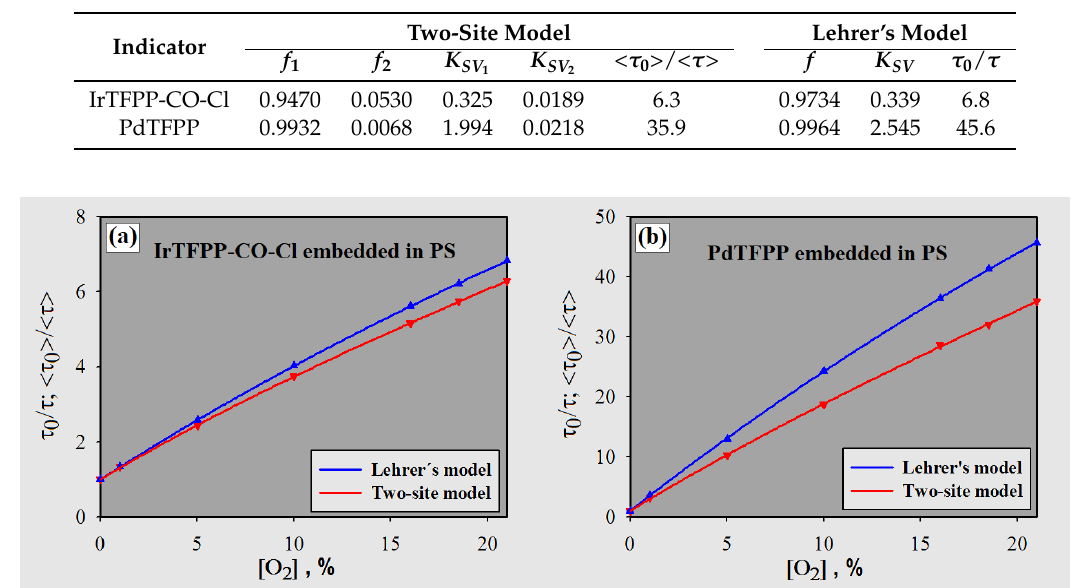
Table 3. Parameters for polystyrene optodes using Equations (5) and (6) (two-site and Lehrer models).